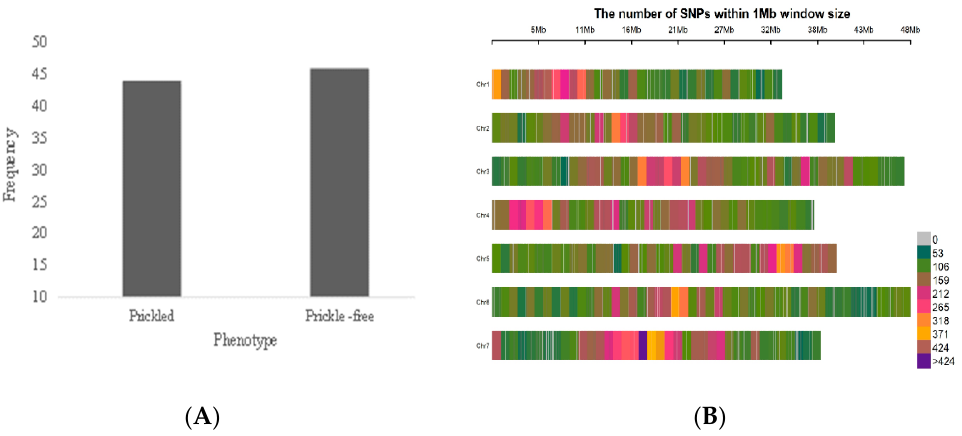
Figure 2. ( A ) Distribution of prickles in F 1 progeny generated from hybridization between prickle-free ‘Joan J’ ( ss ) and prickled ‘Caroline’ ( Ss ) (46:44) and ( B ) distribution of single nucleotide polymorphisms (SNPs) in 1 Mb window size across the raspberry chromosomes. The x-axis represents the distance in base pairs.